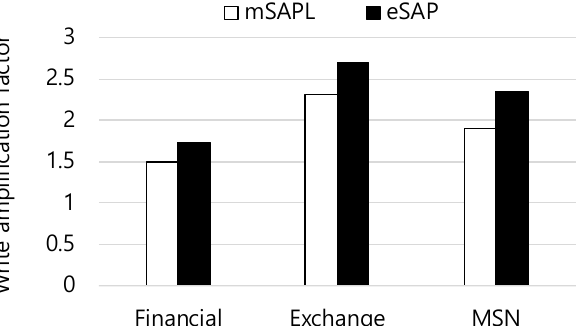
Figure 5. Comparison of Write Amplification Factors (WAFs).